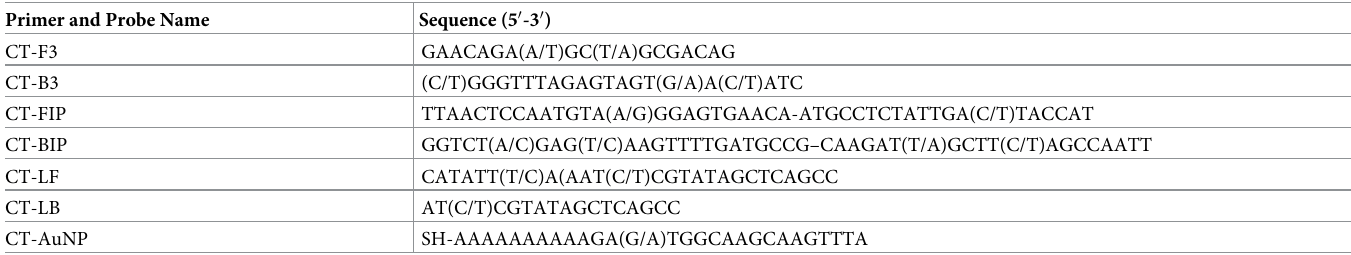
Table 1. Primer and probe sequences of LAMP-AuNP for C . trachomatis detection. Primer and Probe